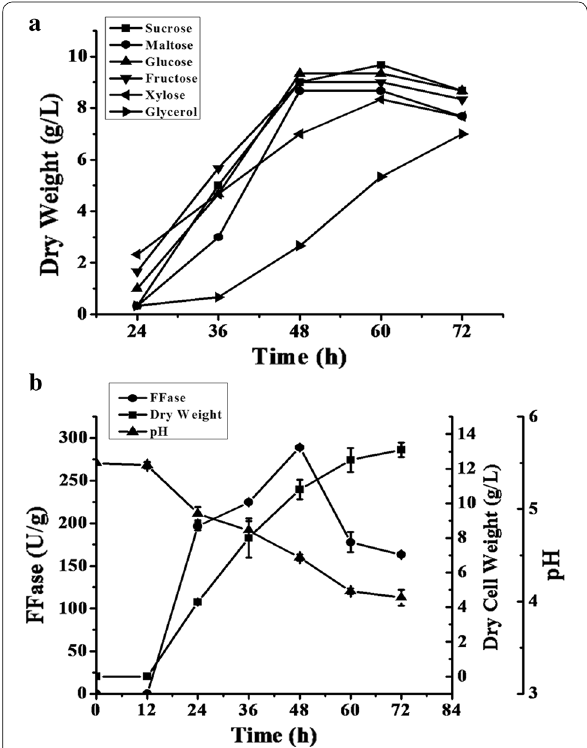
Fig. 4 Growth and FFase production of A. tubingensis XG21 on different carbon sources. a The fungal growth curves by using 1.0% sucrose, maltose, glucose, fructose, xylose or glycerol as carbon sources. b Kinetics of FFase production by A. tubingensis XG21 grown in 8.0% sucrose as carbon